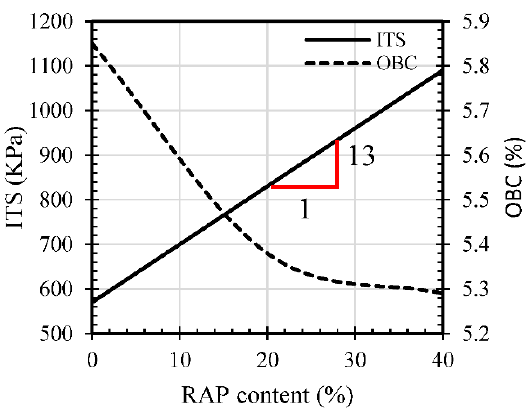
Figure 1. Correlation between ITS and OBC and RAP content based on data reported by Hajj et al. [19].